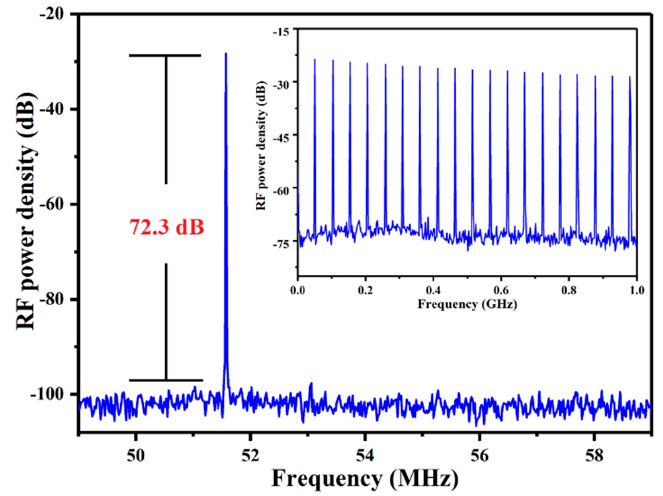
Figure 7. Recorded RF trace.